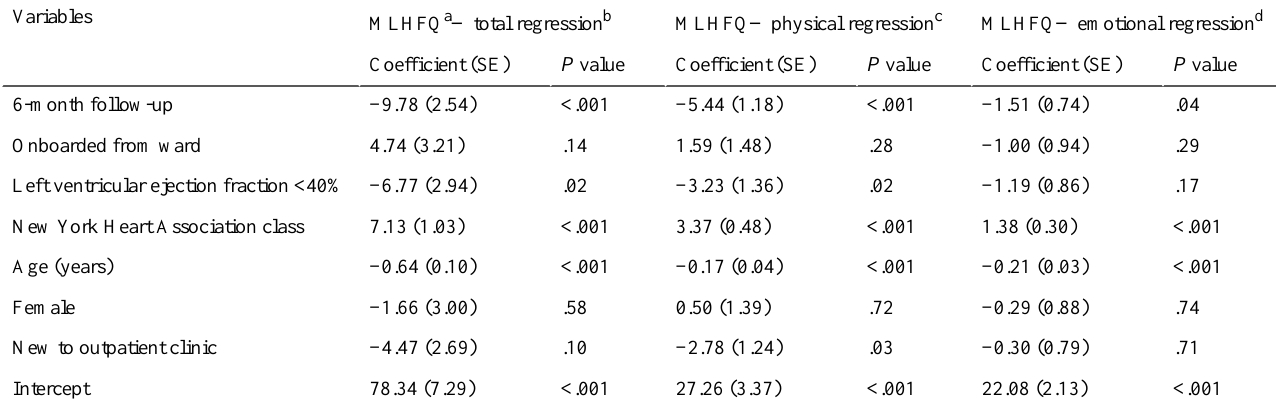
Table 4. Linear regressions showing the effect of 6 months in the Medly program on heart failure–related quality of life when controlled for key demographic and clinical variables.